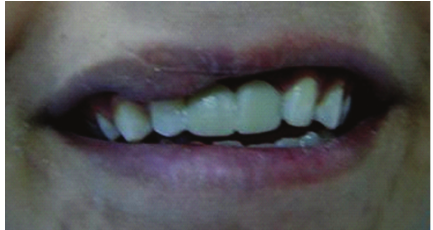
Figure 9: Final view of the restoration having FRC framework veneered with filling composite